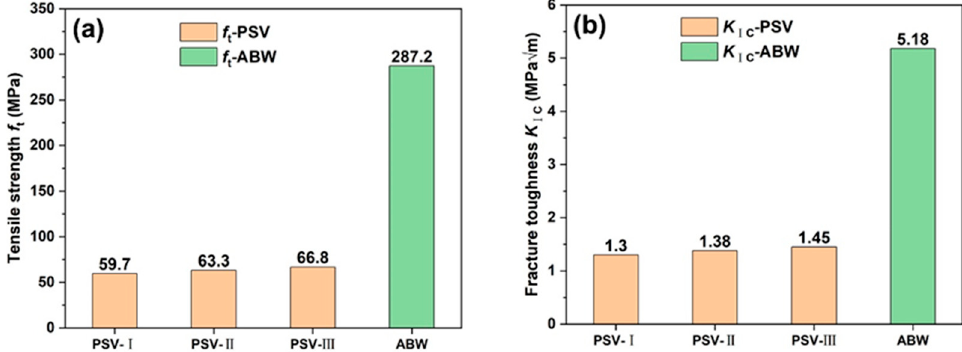
Figure 7. Comparison of the tensile strength ( a ) and fracture toughness ( b ) of PSV and BW.